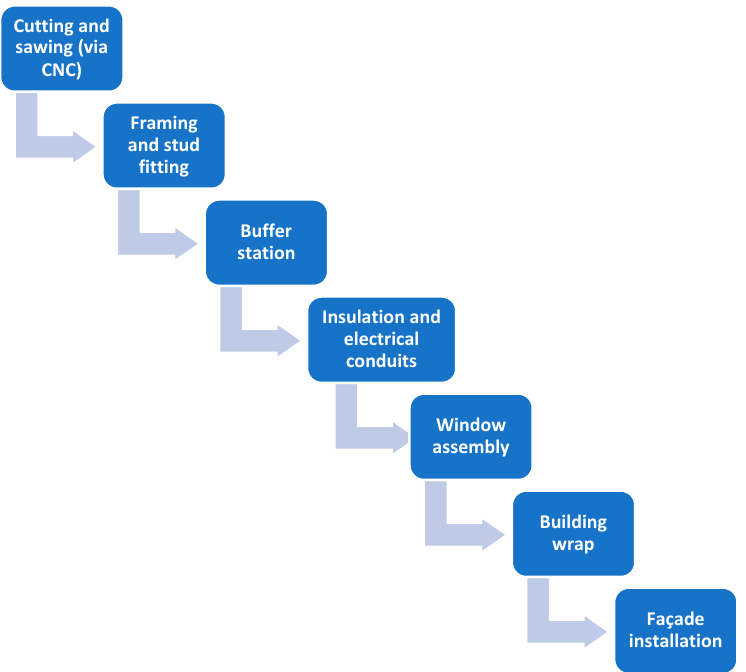
Figure 1. Example of a set of stations which together make a linear assembly line.